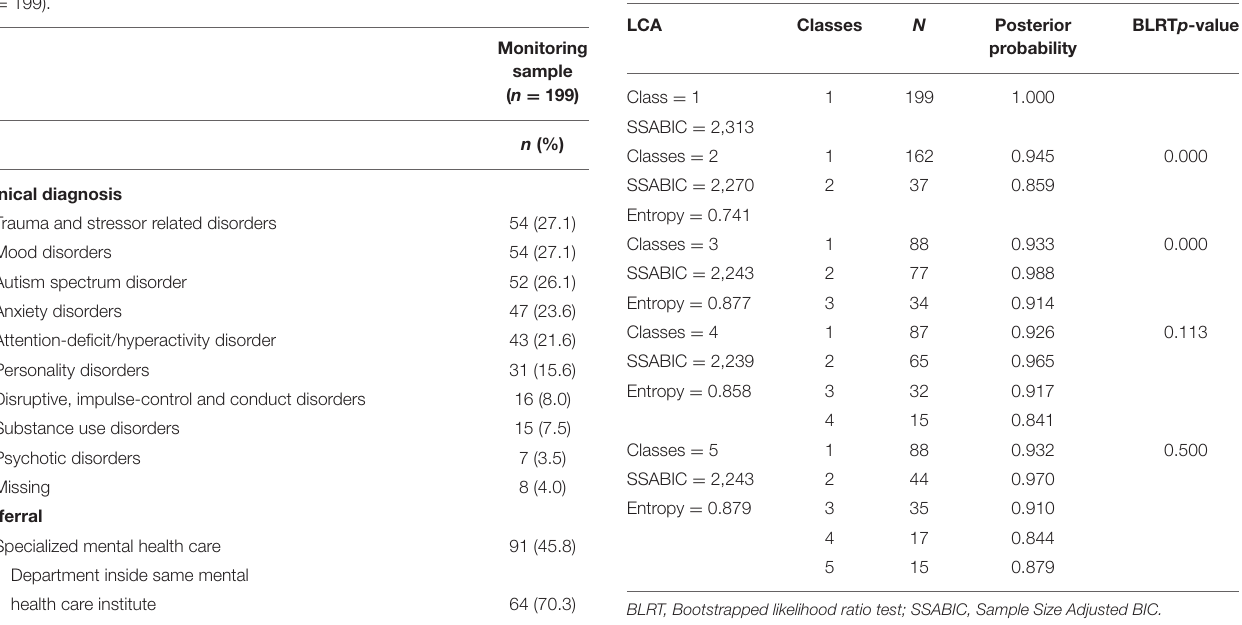
TABLE 3 | Latent class models with up to 5